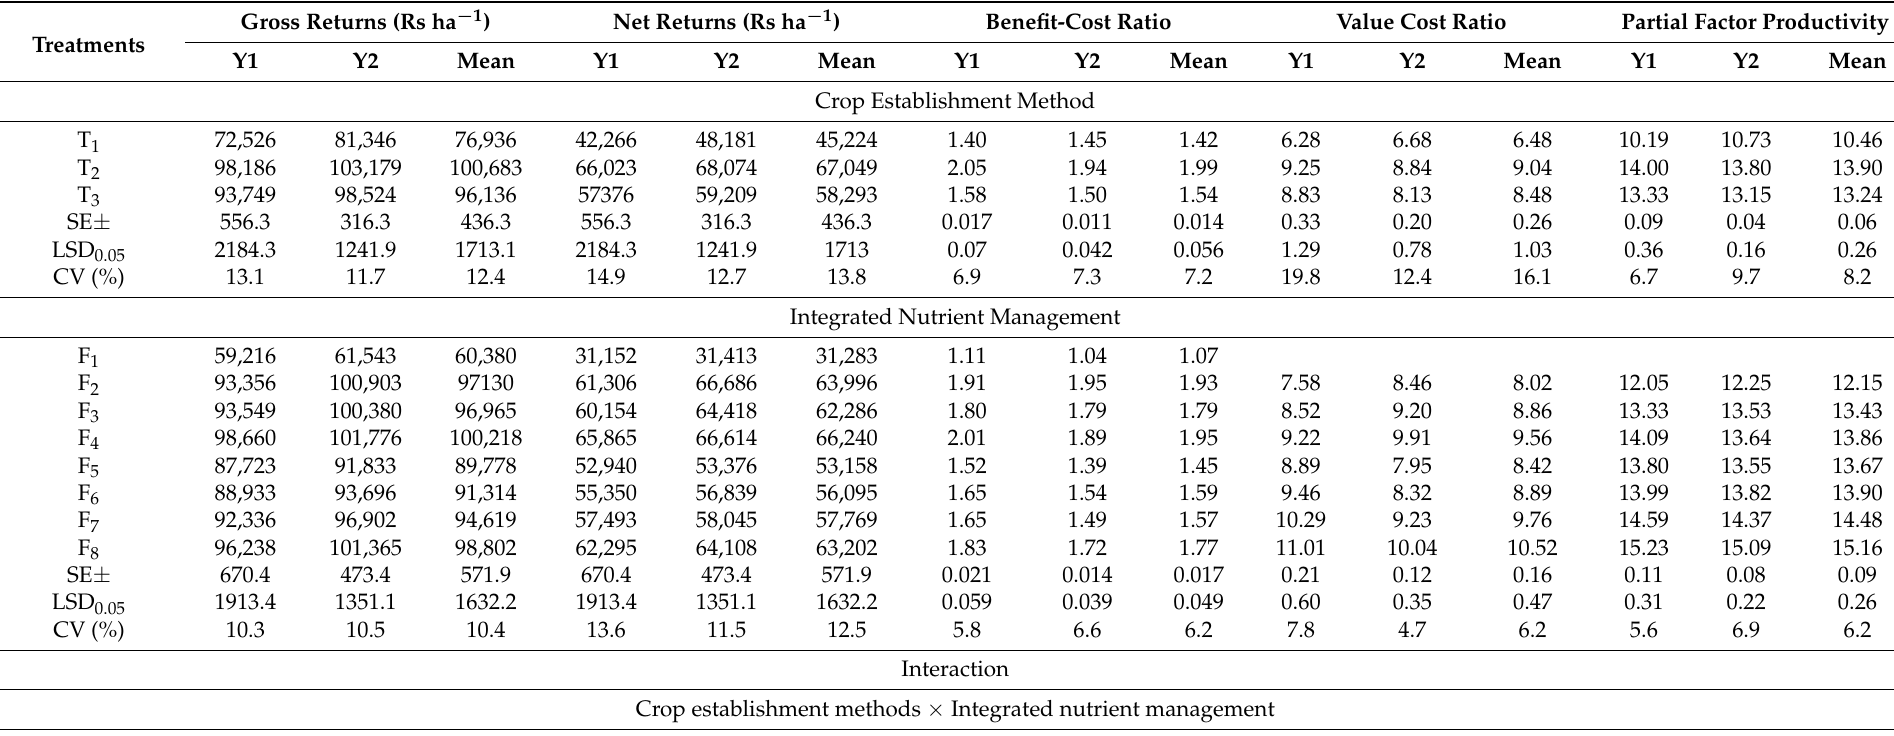
Table 6. Crop establishment methods and integrated nutrient management influenced the profitability of